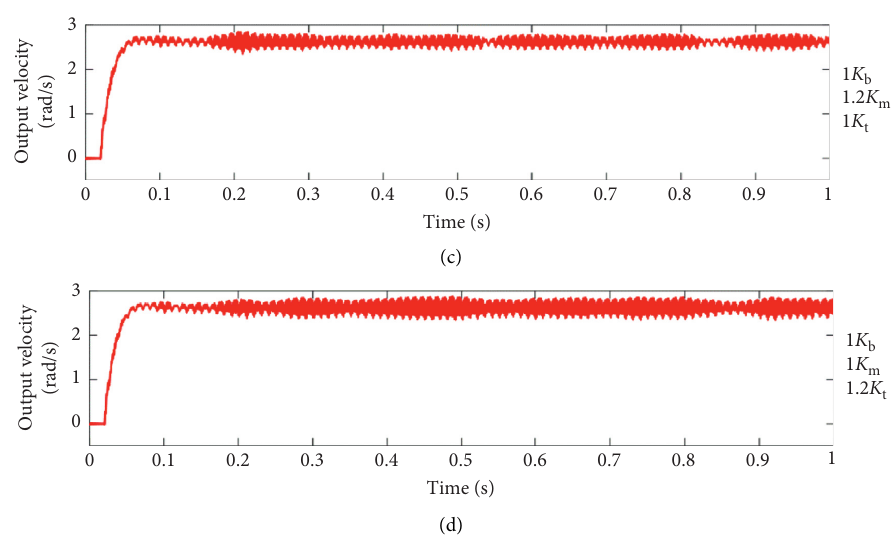
Figure 12: Velocity step responses of different stiffness at 3000rpm.